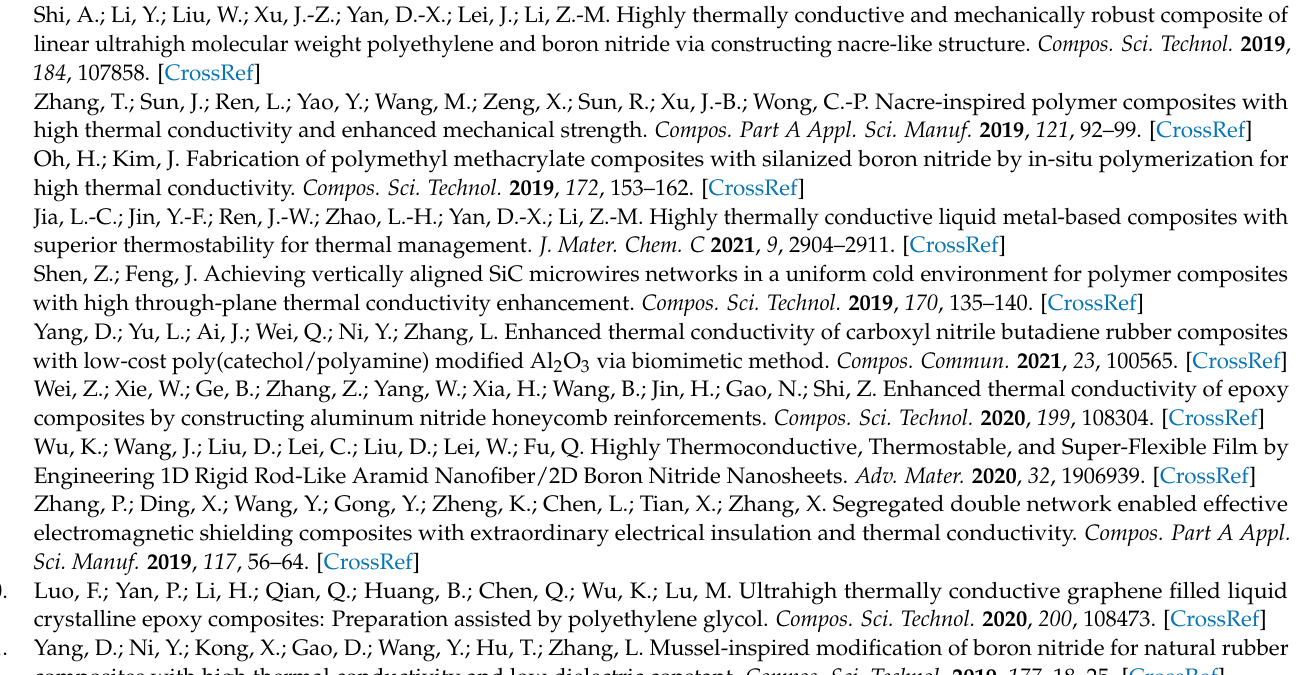
(b) TGA curves of the h-BN, BNNS, and BNNS@Ag. Figure S7: Tyndall effect of the BNNS and BNNS@Ag. Figure S8: SEM image of Kevlar yarn. Figure S9: Photographs of (a) ANF aqueous solution, (b) BNNS@Ag aqueous solution, and (c) ANF/BNNS@Ag mixed solution of after high shear. (d) Schematic diagram of mixed solution of ANF and BNNS@Ag. Figure S10: Photograph of pure ANF film, 30 wt.% ANF/h-BN, 30 wt.% ANF/BNNS, and 30 wt.% ANF/BNNS@Ag thermally conductive composite films. Figure S11: Low-magnification SEM images of the fractured surfaces of (a) pure ANF, (b) ANF/h-BN, (c) ANF/BNNS, and (d) ANF/BNNS@Ag thermally conductive composite films. Figure S12: (a) EDS elements mapping, and (b) the corresponding EDS spectrum of the ANF/BNNS@Ag film. (c) SEM image of ANF/BNNS@Ag film corresponding to (a), and corresponding EDS elements mapping images of (d) C, (e) N, (f) Ag, (g) B, and (h) O. Table